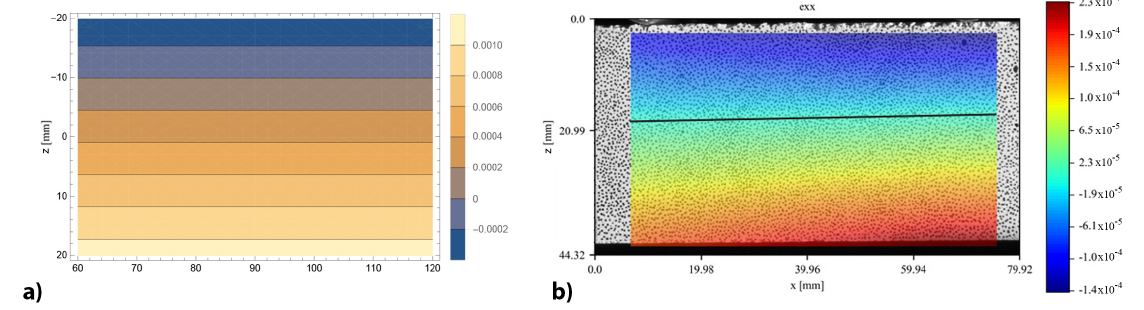
Figure 13. Longitudinal strain contour of 4PB-DIC-LP_02 sample: ( a ) prevision obtained by the bi-modulus model ( b ) results obtained by DIC analysis, the black line represents the position of the neutral